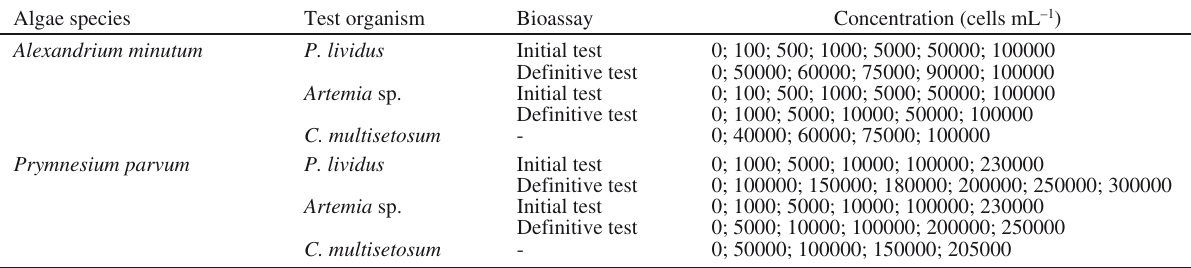
Table 1. – Alexandrium minutum and Prymnesium parvum concentration ranges in the different bioassays. Algae